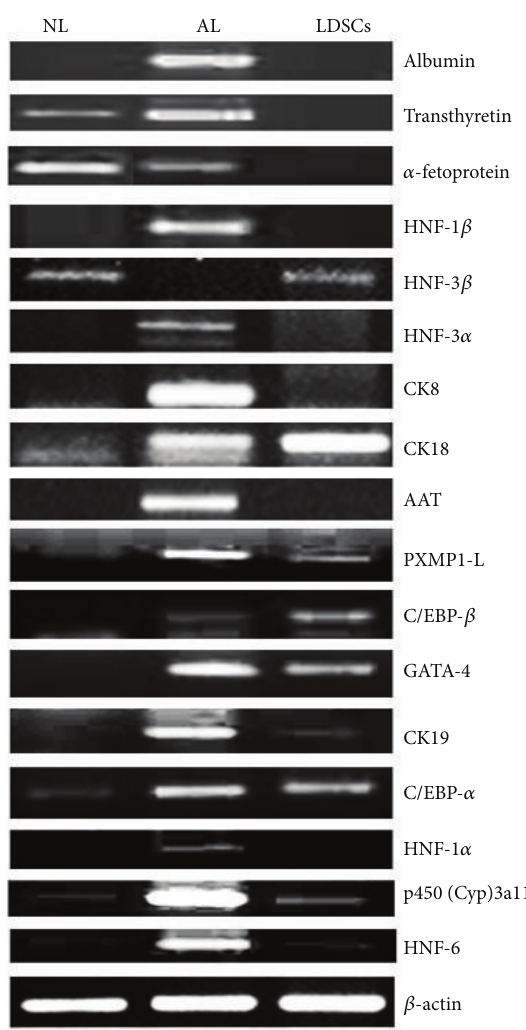
Figure 5: Hepatic markers and their transcription factor mRNA expression by RT-PCR. The RNA was isolated from LDSCs and the mRNA expressions were compared with neonatal liver (NL) and adult liver (AL) for albumin, transthyretin, AAT, AFP, CK8, CK18, CK19, p450 (Cyp)3a11, PXMP1-L HNF-1 𝛼 , HNF-1 𝛽 , HNF- 3 𝛼 , HNF-3 𝛽 , HNF-4 𝛼 , HNF-6, GATA-4, C/EBP- 𝛼 , and C/EBP- 𝛽 . LDSCs show the mRNA expression for HNF-3 𝛽 , CK18, PXMP1-L, C/EBP- 𝛼 , C/EBP- 𝛽 GATA-4, CK18, p450 (Cyp)3a11, and HNF-6, negative for hepatic